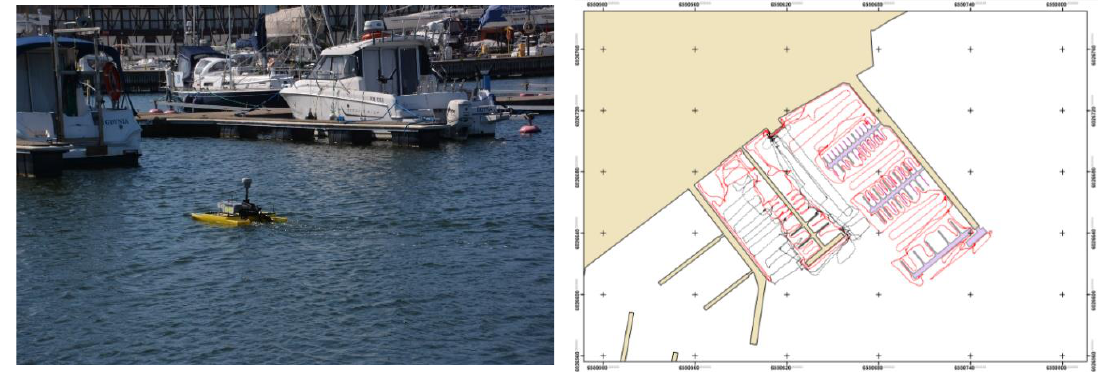
Figure 3. USV during survey (left) and surveyed lines (right) at end of April surveys.